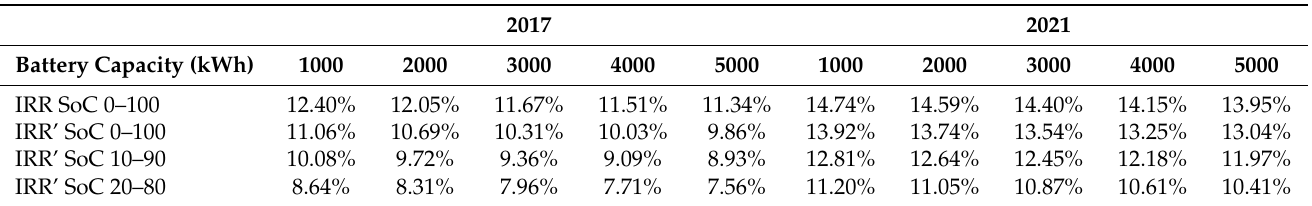
Table 5. Introduction of real-world assumptions and decreasing profitability, comparison of 2017 and 2021 MOO performance (c-rate =